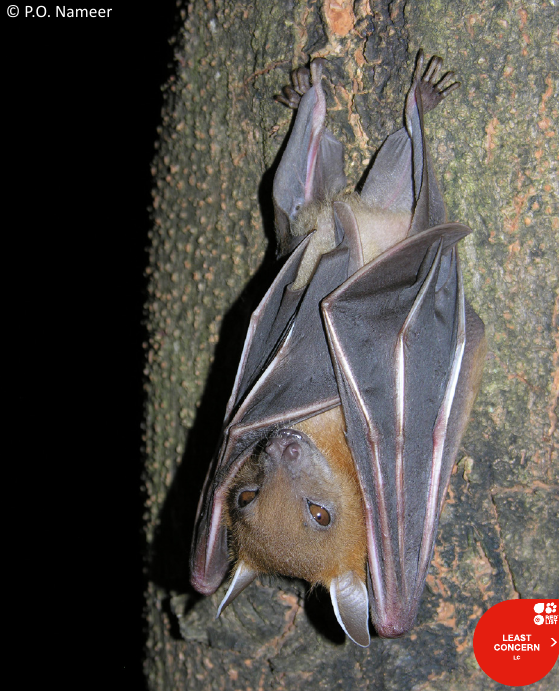
Image 8. Greater-shortnosed Fruit Bat Cynopterus sphinx